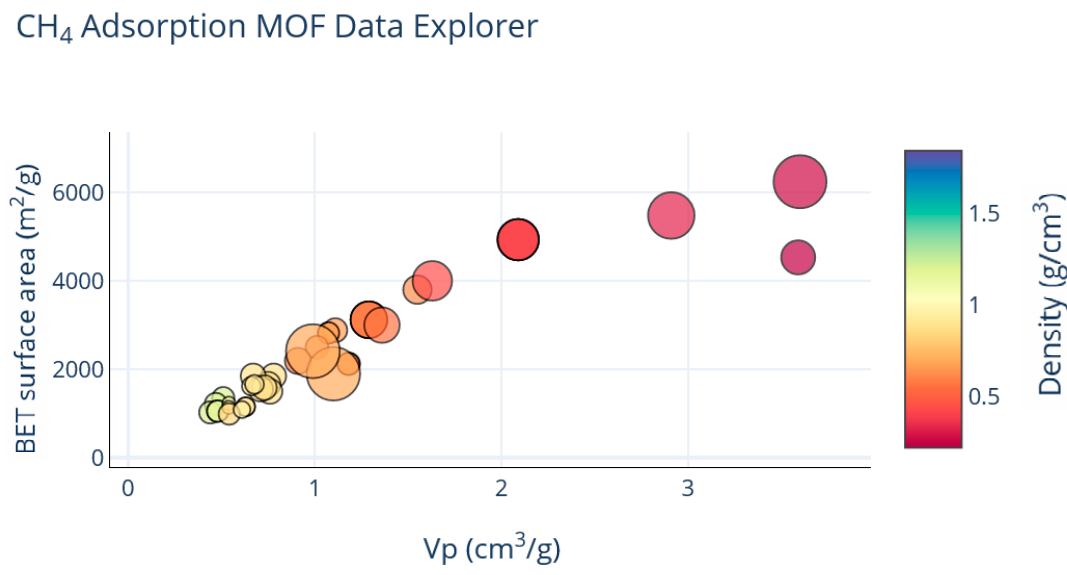
Figure 2. Relationship between BET surface area and the pore volume, V p , of MOFs. Each point represents a MOF. The data points are color-coded by MOF density and the diameter of each circle represents the largest cavity diameter (LCD) of each MOF.